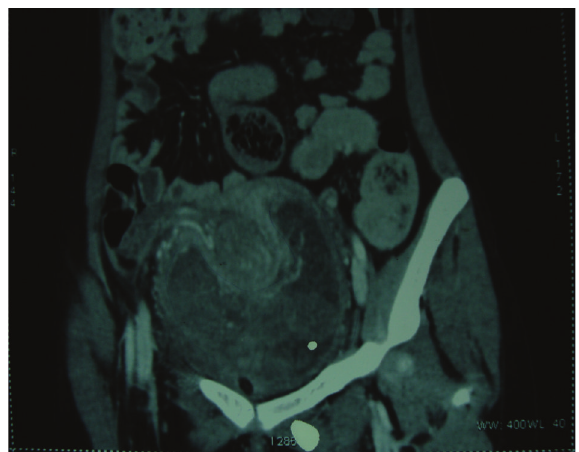
Figure 1: Coronal section computed tomography showing hetero- geneously enhancing mass lesion engulfing the uterus, broad liga- ment and accompanying vessels.